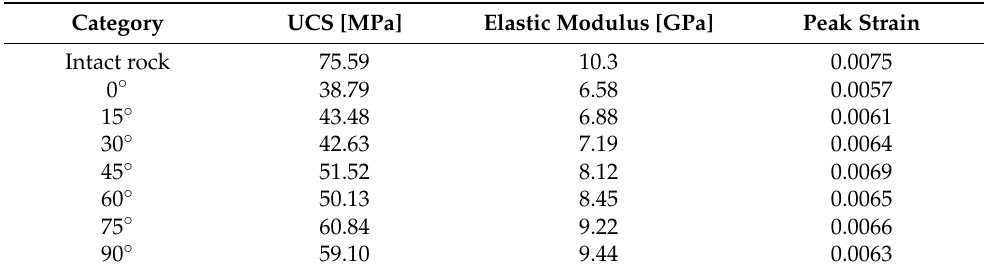
Table 4. Mechanical parameters of numerical simulation under uniaxial compression of rock with different fracture